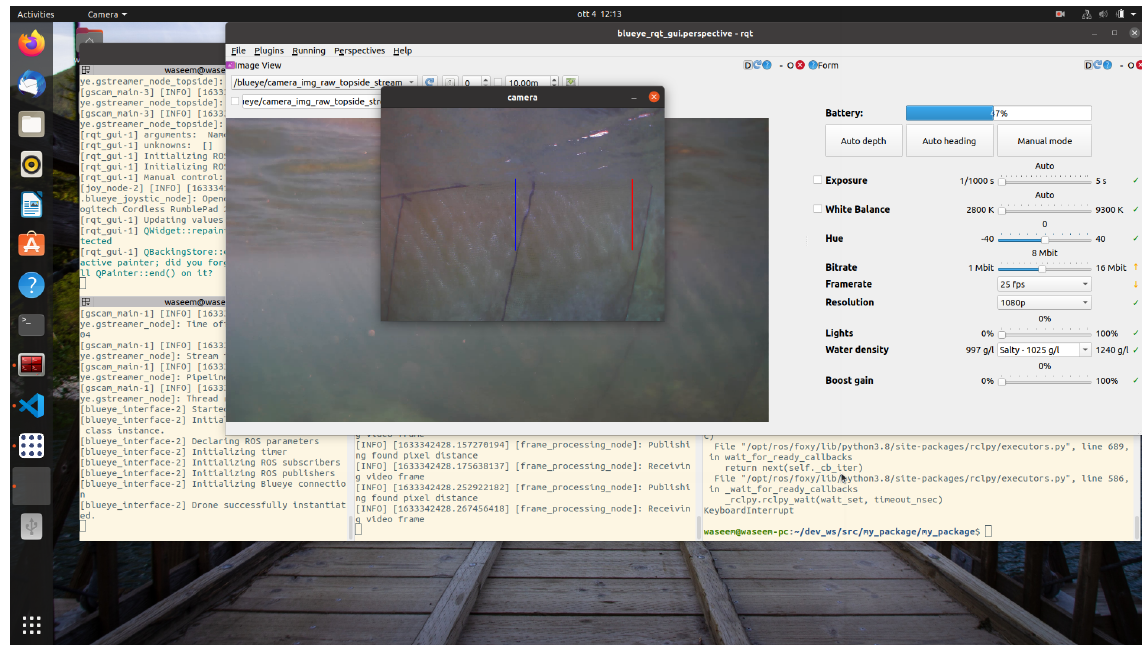
Figure 19. Experiments screen captured during